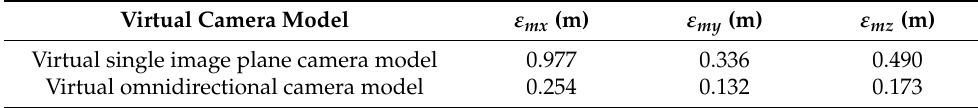
Table 1. Location errors in different virtual camera models.